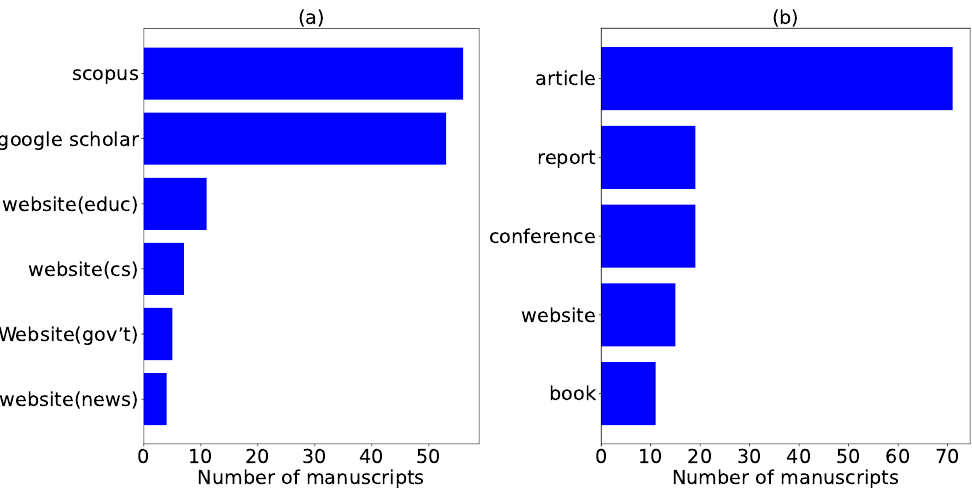
Figure 2. ( a ) Displays the total number of manuscripts extracted from each internet source, and ( b ) vi- sualizes the total number of manuscripts associated to each document type.